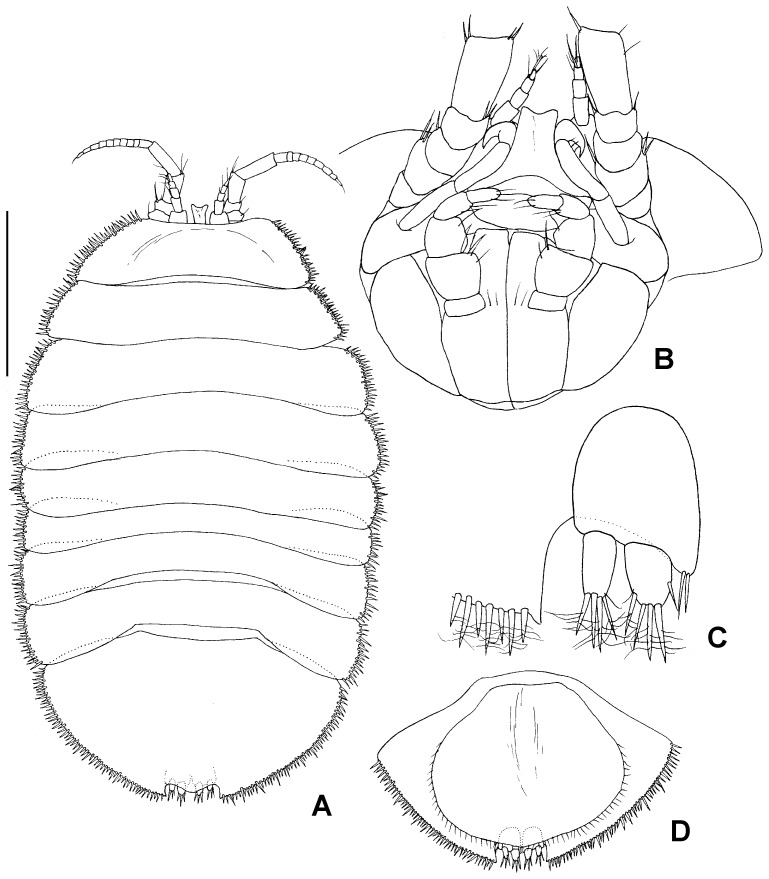
Paratype ZMH K-44089, female.A) dorsal view, B) head, vental view, C) inserted uropod, D) pleotelson, ventral view, scale for total view – 1 mm